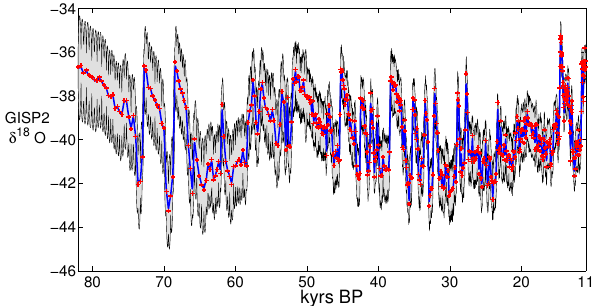
Fig. 2: Gaussian Process (GP) fit to the GISP2 data set. The raw data is shown in red with the mean from the GP in blue and the upper and lower 3 σ levels in